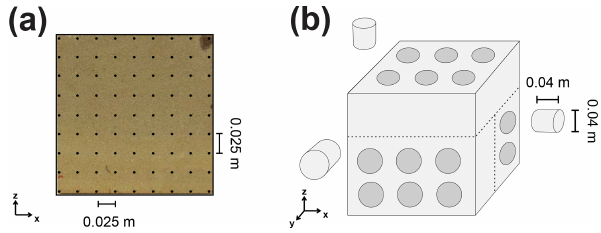
Figure 3. (a) Sampling locations for the noninvasive measurements, including P-wave and S-wave velocity and X-ray fluorescence, dis- played for the face XZ back of OSB1_c. (b) Schematic of the ex- traction strategy for sampling the rock